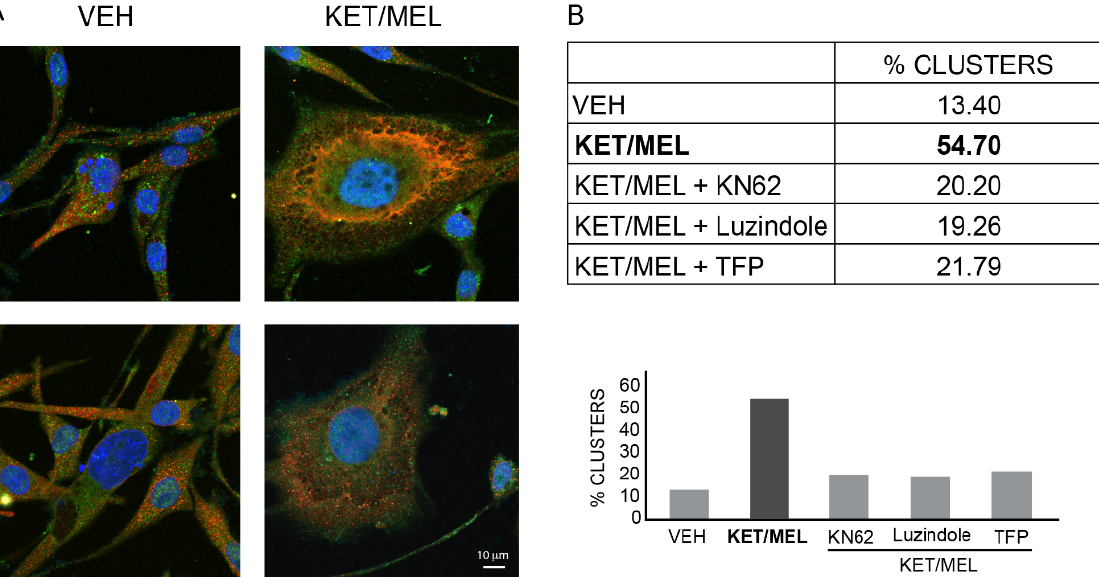
Figure 6. Participation of CaMKII, melatonin receptors, and calmodulin (CaM) on cluster formation. Olfactory neuronal precursors were cultured for 4 days and then preincubated in serum-free medium with the VEH, 10 µM KN-62, an inhibitor of CaM Kinase II, 10 µM luzindole, an MT1 and MT2 melatonin receptor antagonist, or 10 µM trifluoperazine (TFP), a CaM antagonist, during 15 min. Afterwards, the combination of 10 − 7 M ketamine with 10 − 7 M melatonin (KET/MEL) was added for 6 h. Cells were fixed and stained with an anti-nestin an anti-doublecortin antibodies, followed by secondary antibodies as described in Materials and Methods. Panel A shows representative images of clusters formed in the presence of the VEH or the KET/MEL combination. Bar = 10 µm. Panel B shows a table and a bar graph with the results of frequency formation of clusters. Results are the mean of 7000 cells/coverslip analyzed by duplicate per treatment (n = 4). Each coverslip has an area of 113 mm 2 which nearly corresponds to 340 fields observed with the 40X objective. Coverslips were scanned by confocal microscopy with the Image J (NIH) and Zenblue (Zeiss) software. The experiment was repeated two times.